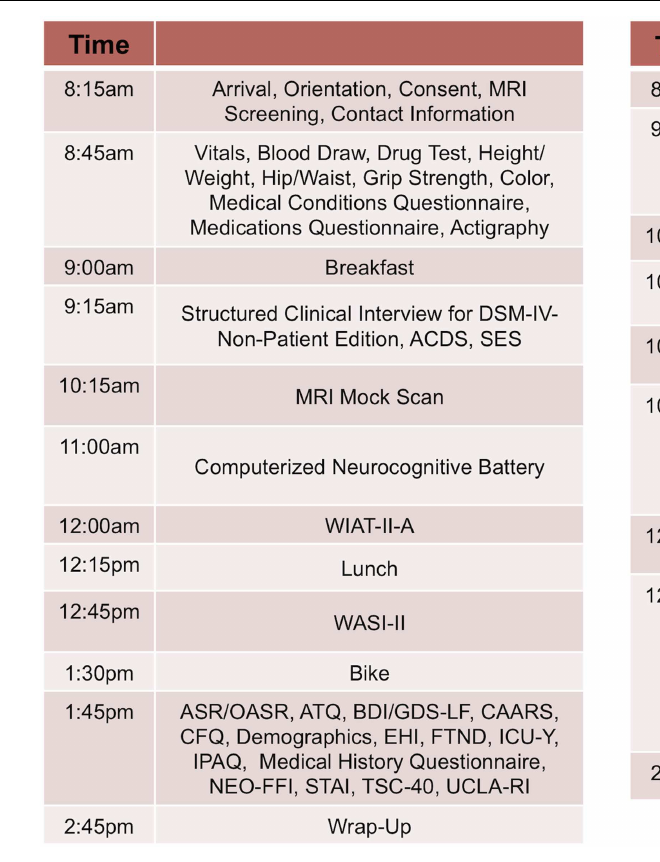
FIGURE 2 | Sample schedule for adult participants in NKI-RS. This figure illustrates the 2-day assessment schedule for adult participants (ages 18–85years) in the Nathan Kline Institute-Rockland Sample (NKI-RS) protocol. Abbreviations for the assessments: ANT, Attention NetworkTask; ASR, Adult Self Report; ATQ, AdultTemperament Questionnaire; BDI, Beck Depression Inventory-II; CAARS, Conners’ Adult ADHD Rating Scales; CASI-AOD, Comprehensive Adolescent Severity Inventory – Alcohol and Other Drugs; CHRLS, Cambridge-Hopkins Restless Leg Syndrome Questionnaire; CFQ, Cognitive Failures Questionnaire; DOSPERT, DOSPERT RiskTaking Scale; GDS-LF, Geriatric Depression Scale-Long Form; OASR, Older Adult